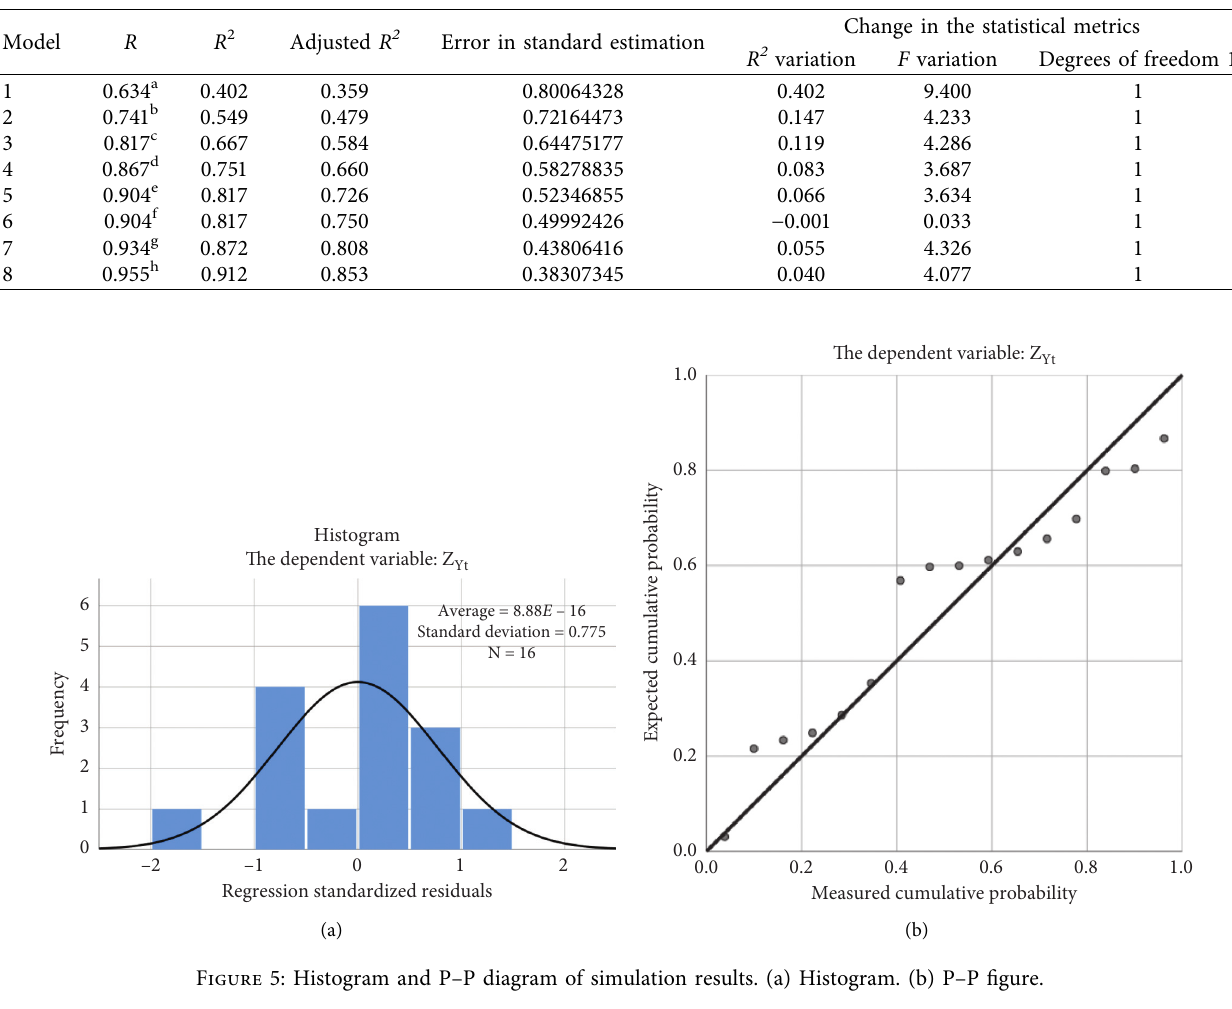
Table 4: Model variances.